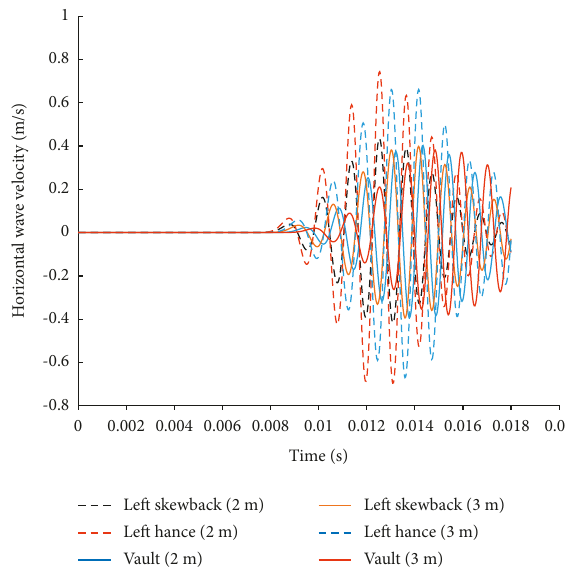
Figure 12: Horizontal wave velocity of each measuring point in tunnel when the width of discontinuity is 2 m and 3m, respectively.